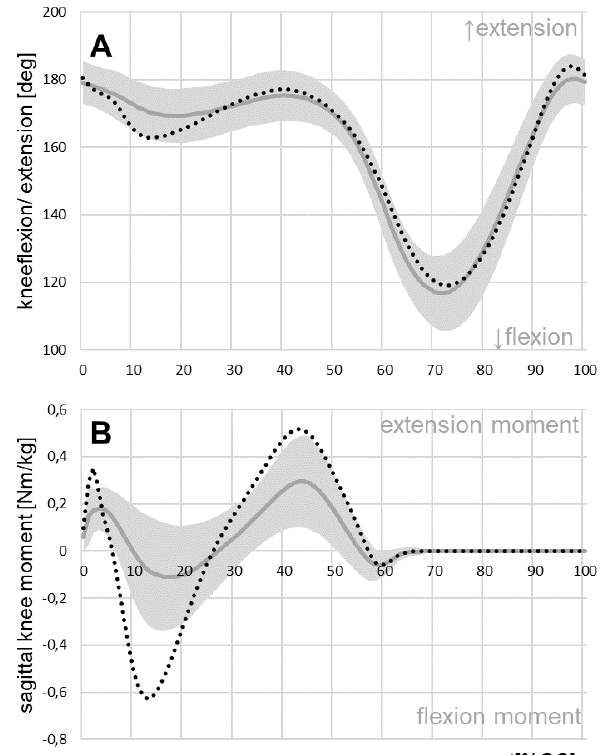
Figure 2: Mean parameters for the residual knee joint of the TTs with standard deviation (grey) and for the control group (dotted, black). A: mean pattern of knee motion, B: external sagittal moment acting on the knee